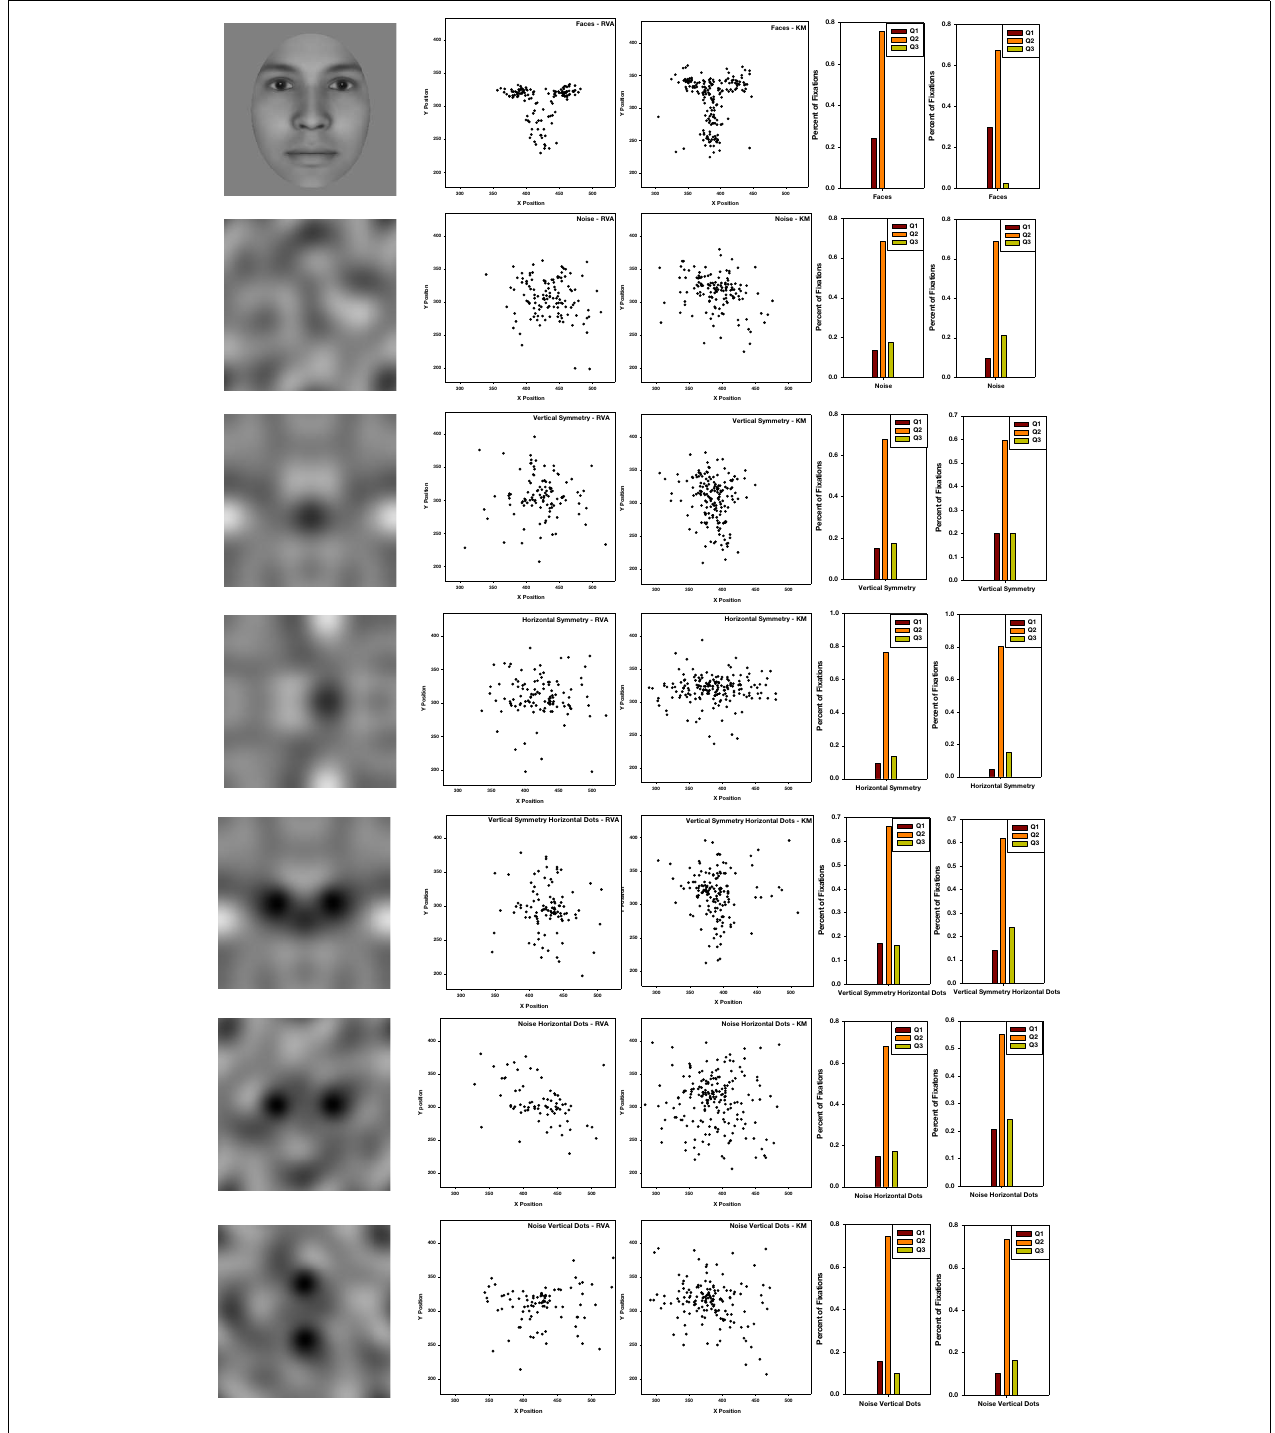
FIGURE 12 | Fixation patterns for two observers while scanning a realistic face or different versions of the noise images. Histograms to the right show the number of fixations within a region containing the eyes or within regions above or below the